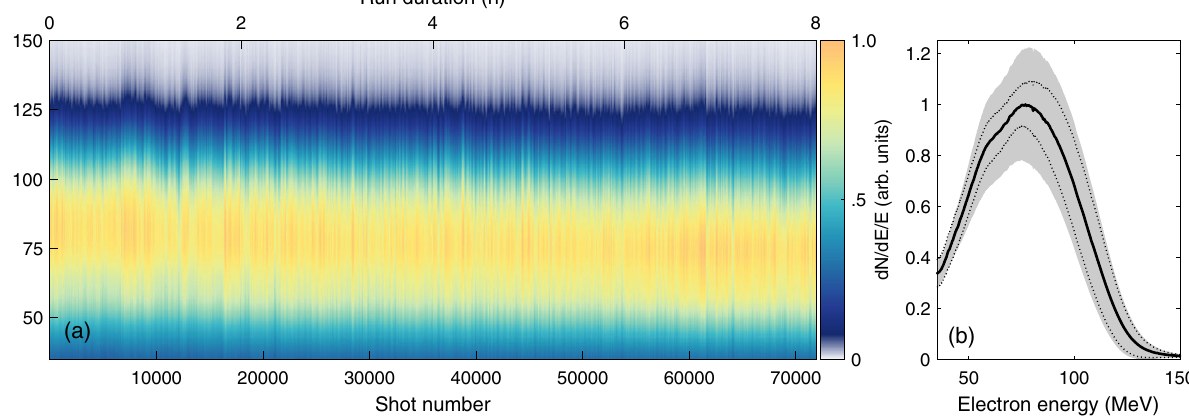
FIG. 4. Electron energy spectra ð d N= d E=E Þ . (a) As function of shot number and time (waterfall). (b) Average spectrum with its standard deviation (grey area) and the standard deviation of normalized spectra indicating fluctuations independent of charge fluctuations (dotted